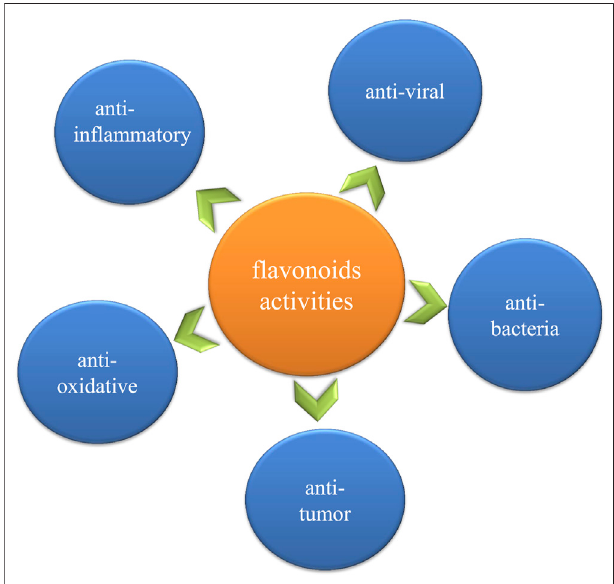
FIGURE 1 | Schematic presentation of the biological activity of fl